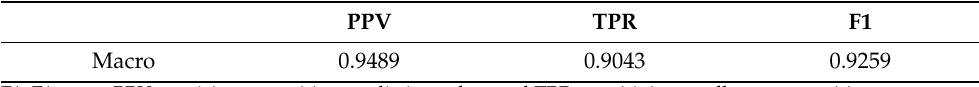
Figure 8. CNN classification results on two-fold cross validation: green as correctly classified instances and red as incorrectly classified instances, https://drive.google.com/drive/folders/1Q4 1lGFpawPvYmPZ8SNK3sgsuvjs4kB45?usp=sharing (accessed on 3 March 2022). Table 2. Quantitative results on two-fold